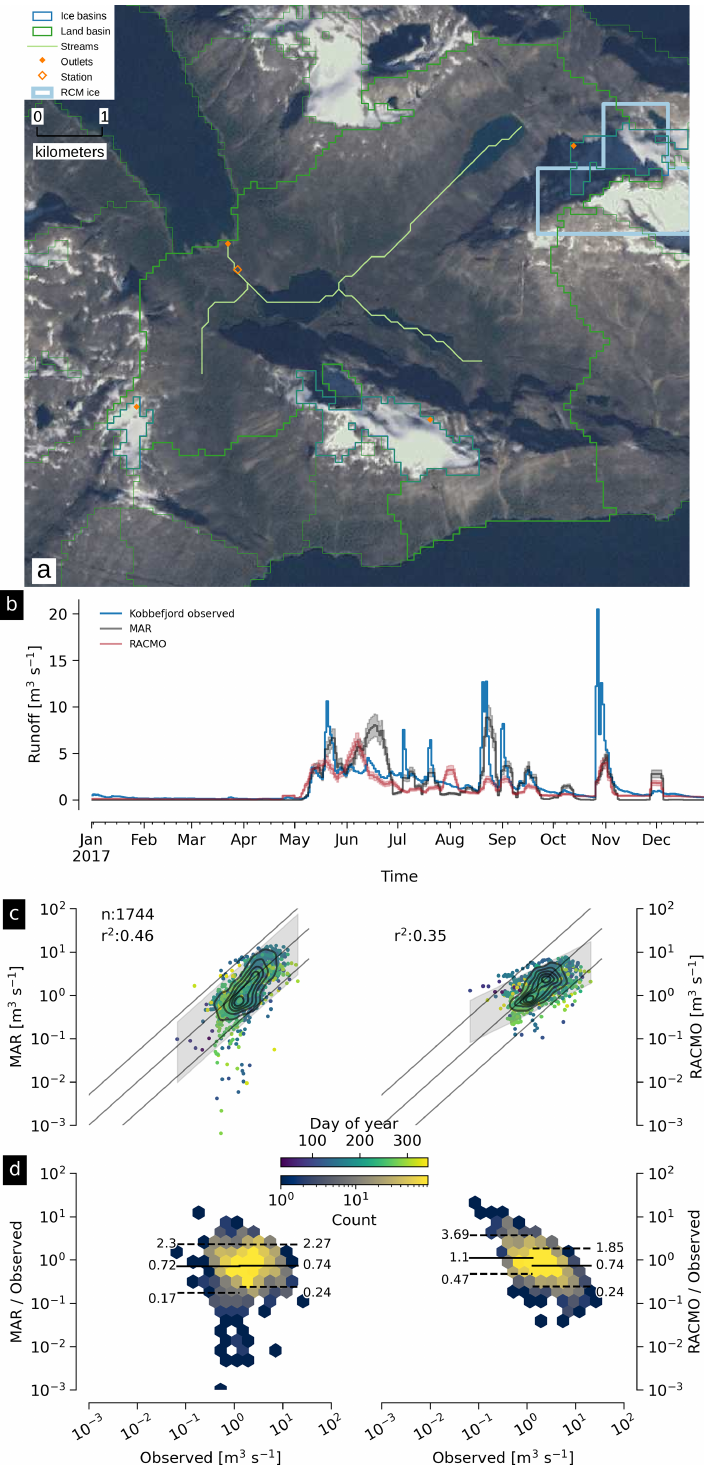
Figure 14. Graphical summary of Kobbefjord outlet, basin, and discharge (Kb in Fig. 1). See Sect. 3.4 for a general overview of graphical elements and Sect. 4.2.5 for discussion of the Kobbefjord basin. Basemap from Howat et al. (2014) and Howat